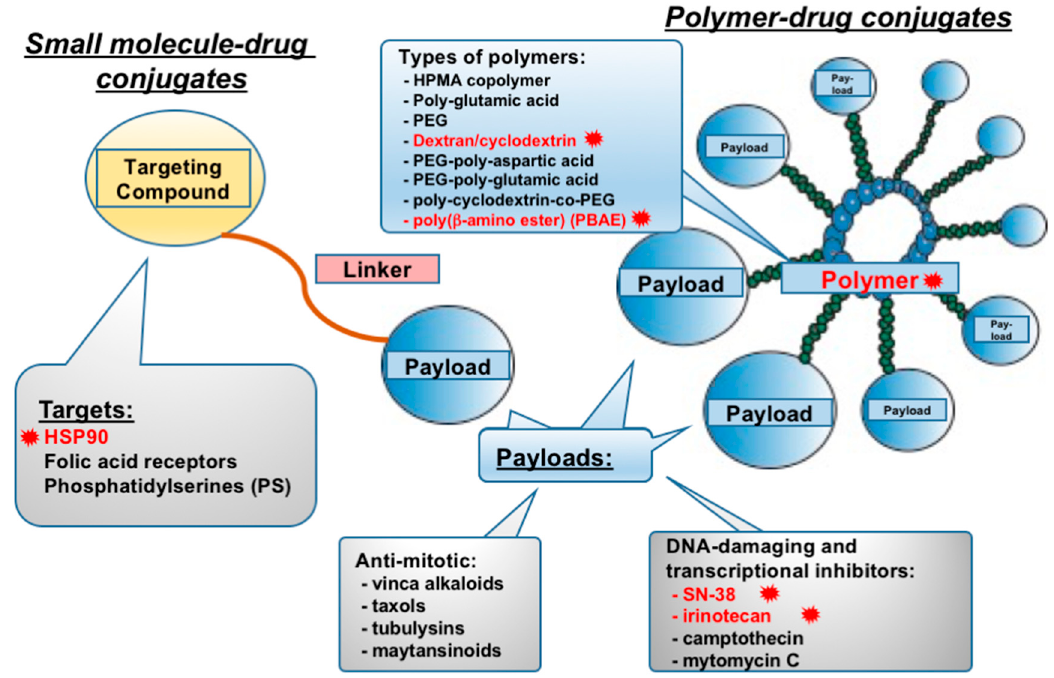
Figure 2. Small molecule-drug conjugates (SMDCs) and polymer-drug conjugates (PDCs). Schematic representation of structural features, targets, and mechanism of action. While sharing common payloads, the targeting mechanism differs (see text). Highlighted in red are the targets, polymers, and cytotoxic compounds assessed in the SCLC setting; black font indicates moieties under investigation and showing promise in other cancers, but not yet in SCLC.